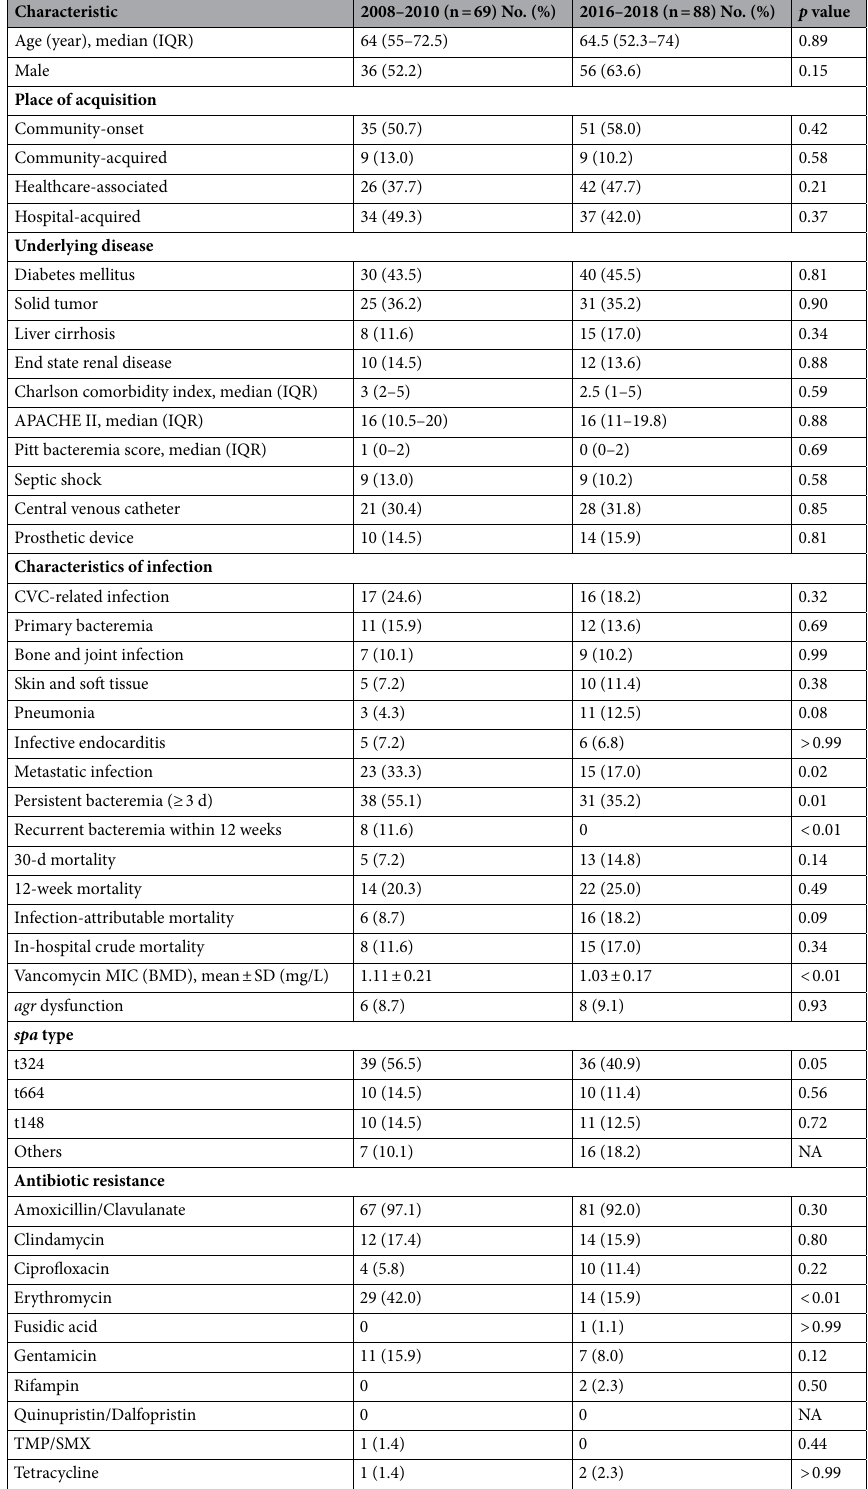
Table 2. Univariate analysis of clinical and microbiological characteristics of 157 patients with sequence type 72 MRSA